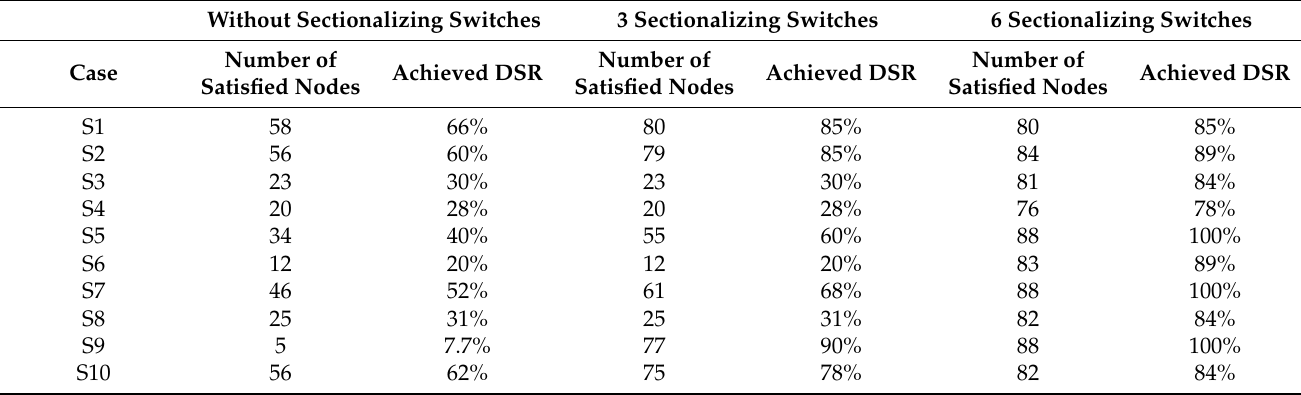
Table 4. Results of the tested instances on a real